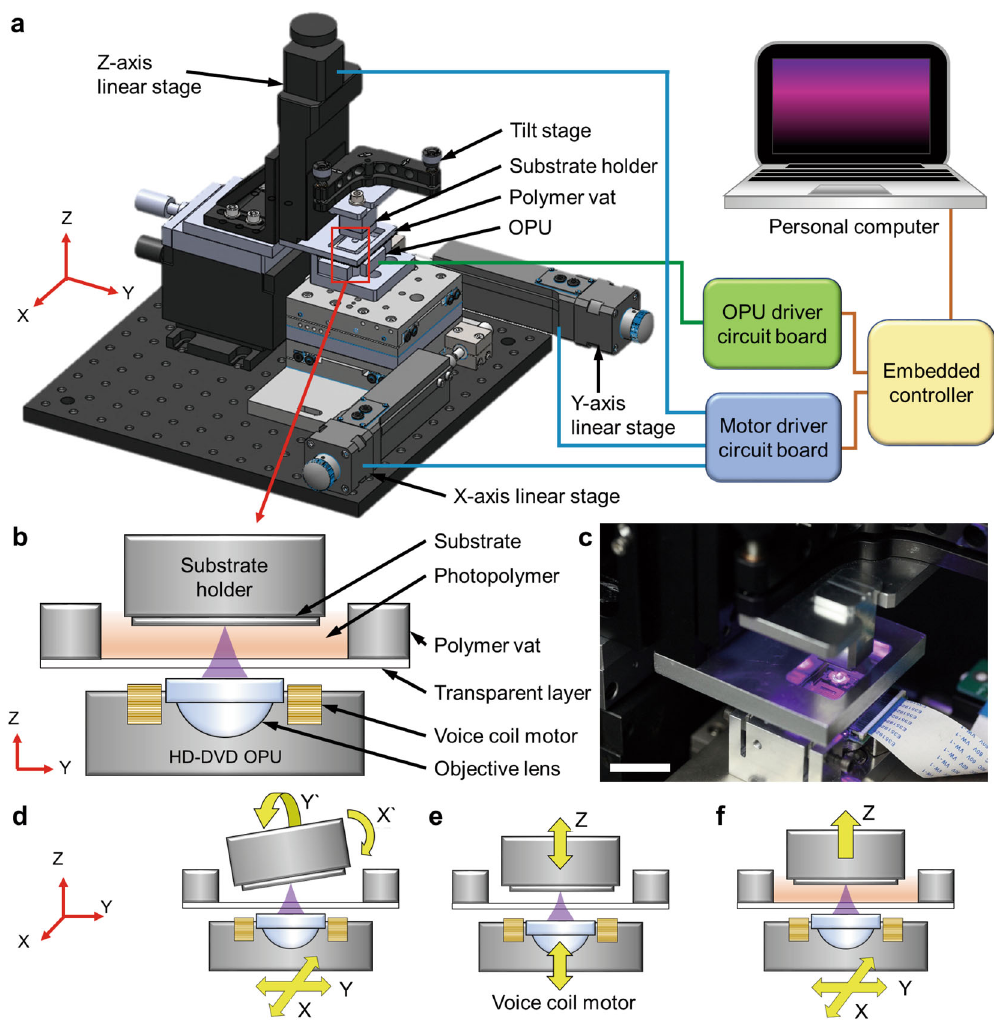
Fig. 2 Developed 3D printer using high-de fi nition digital versatile discs (HD DVDs) optical-pickup-unit (OPU) as core optical module by focusing laser beam of 405 nm wavelength to cure photopolymer in Vat. a Mechanism of printer with inverted stereolithography (STL) design and control system diagram. b Detailed diagram of optical path. c Photograph of system during printing (scale bar represents 2 cm). d Substrate tilting diagram ( X ′ and Y